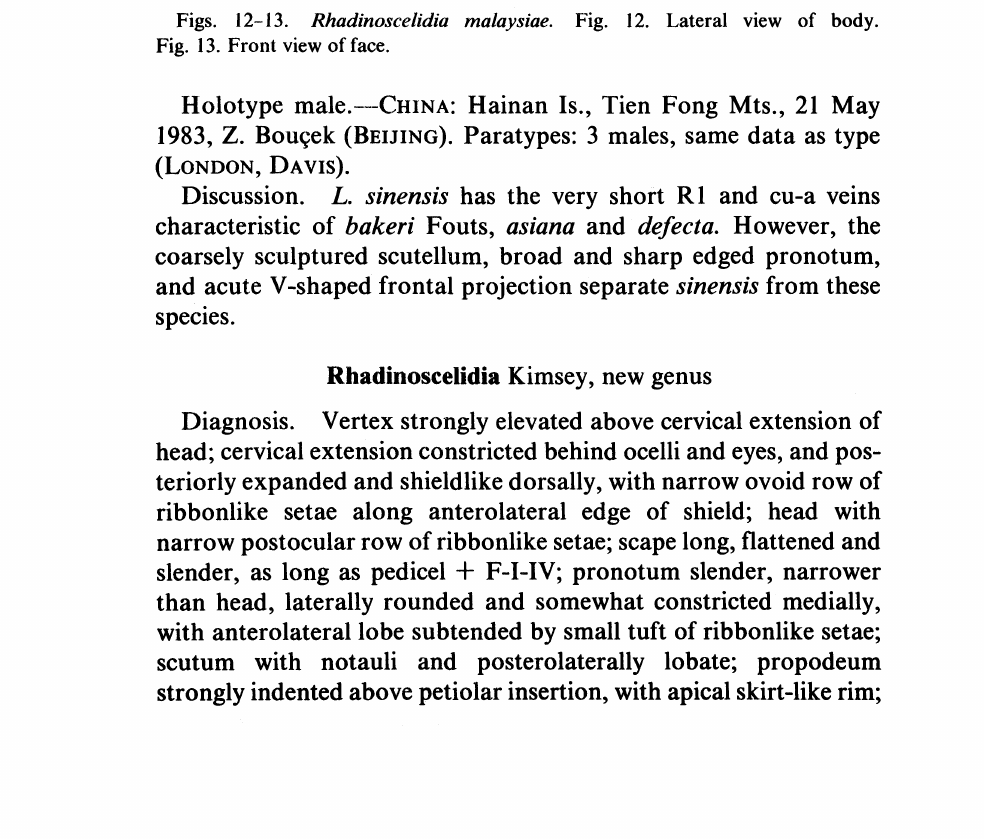
Figs. 12-13. Rhadinoscelidia malaysiae. Fig. 12. Lateral view of body. Fig. 13. Front view of